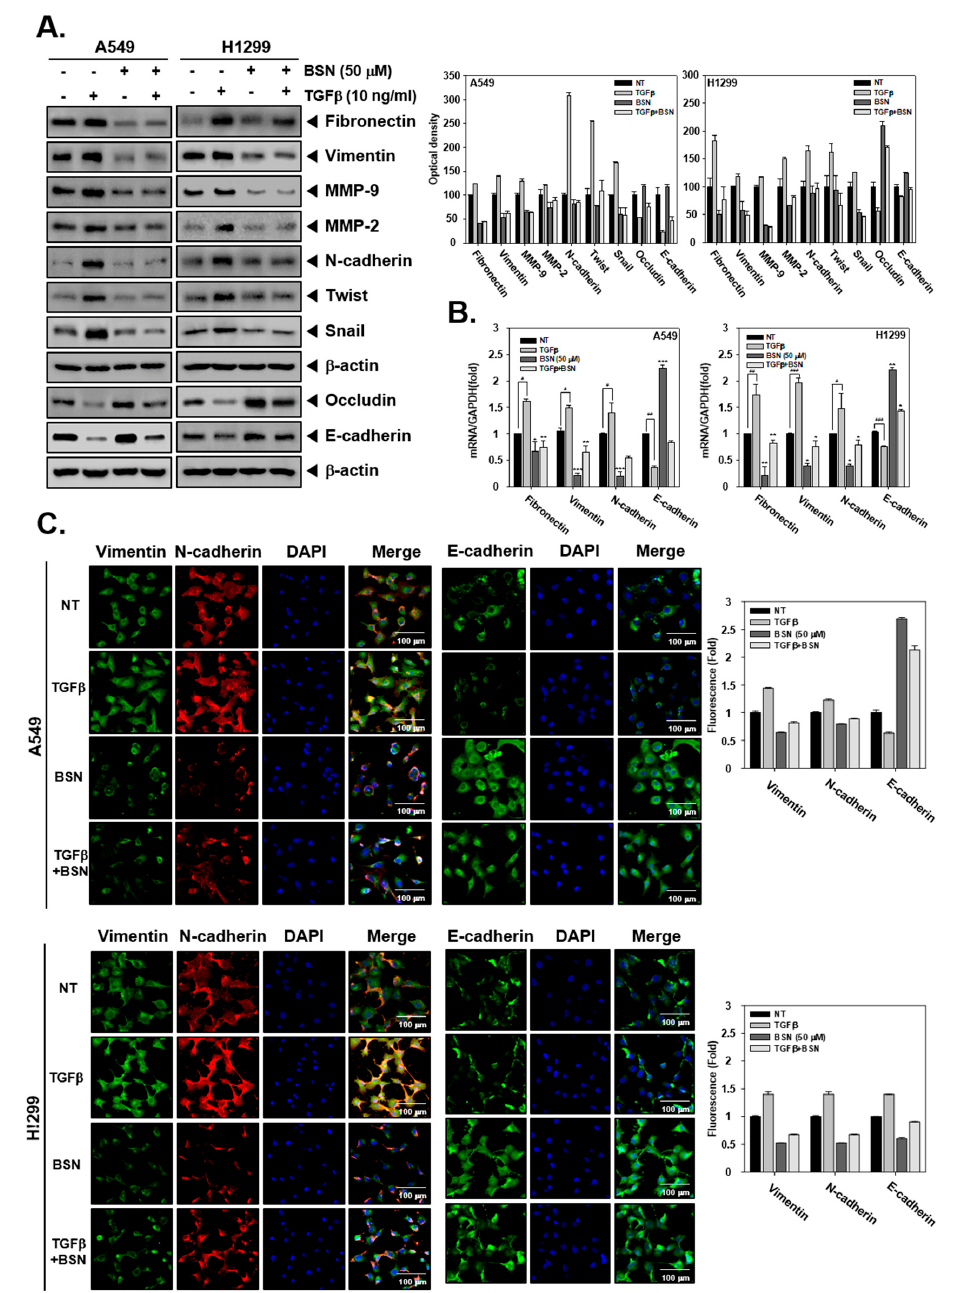
Figure 2. Effects of BSN on transforming growth factor beta (TGF- β ) induced EMT process. ( A ) Cells were treated with TGF- β (10 ng/mL, − /+), BSN (50 μ M, +/ − ), or the combination condition (+/+) for 24 h and western blotting was performed. The results shown are representative data of experiments. Graphs represent band intensities of indicated proteins. ( B ) Cells were treated as described above and real-time quantitative PCR was performed. Data represent means ± SD; ### p < 0.001 vs. non-treated (NT) cells, ## p < 0.01 vs. non-treated (NT) cells, # p < 0.05 vs. non-treated (NT) cells, *** p < 0.001 vs. TGF- β treated cells, ** p < 0.01 vs. TGF- β treated cells * p < 0.05 vs. TGF- β treated cells. ( C ) The cells were treated as described above and immunocytochemistry was carried out. Quantitative analysis of the fluorescence intensities was